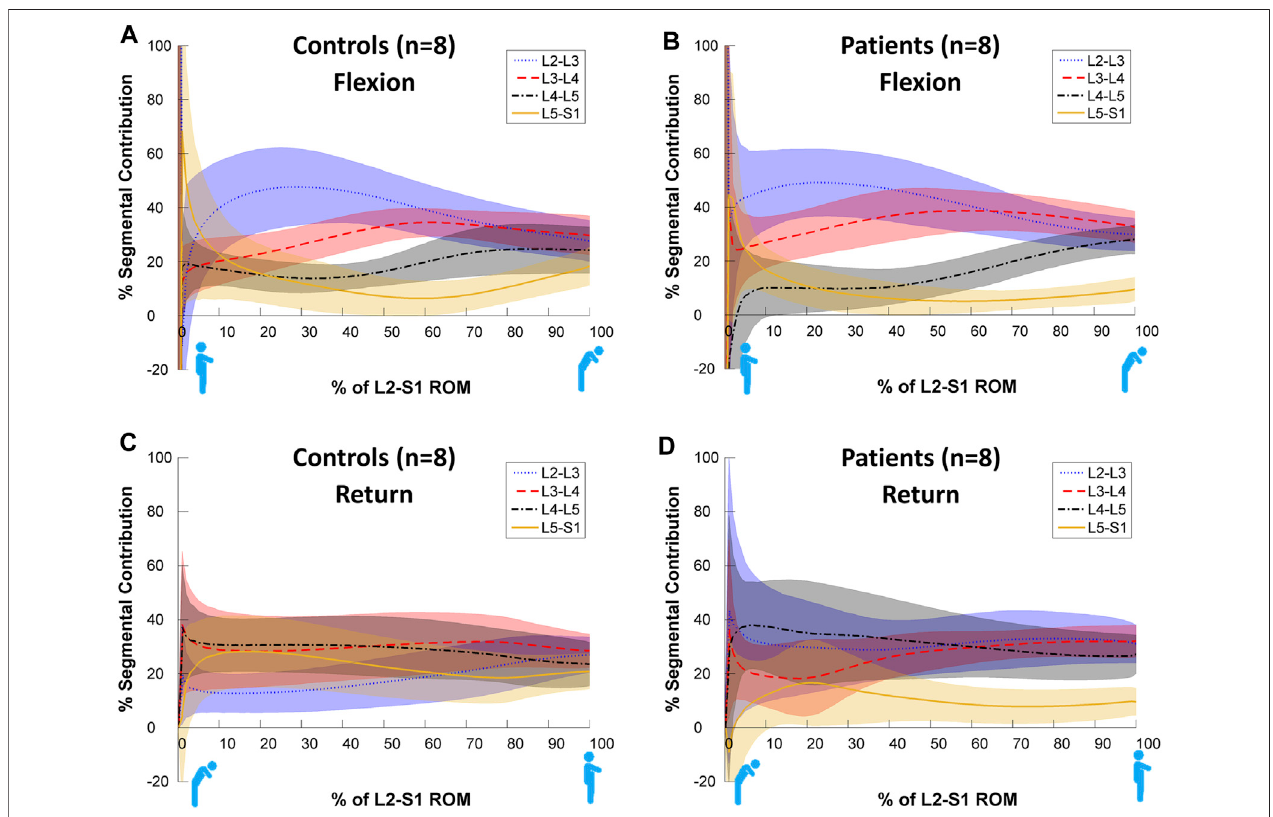
FIGURE 5 | Average segmental contribution to return from fl exion with 95% con fi dence intervals (shaded areas) in the Patient-control sub-study cohorts. (A) : Control Flexion, (B) : Patient Flexion, (C) : Control Return, (D) : Patient Return.